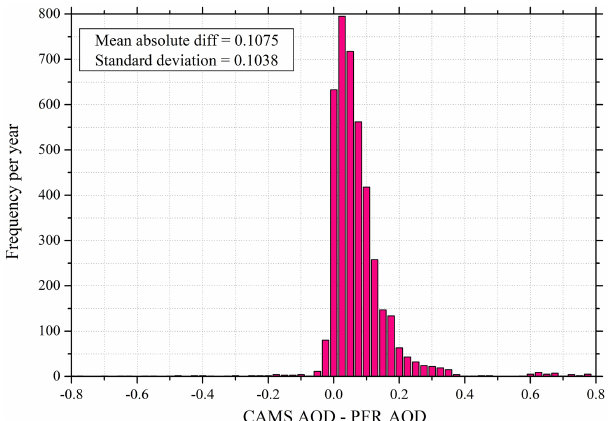
Figure 10. Frequency histogram of differences between the CAMS and the PFR AOD at the Izaña station together with the mean abso- lute difference and standard deviation metrics.